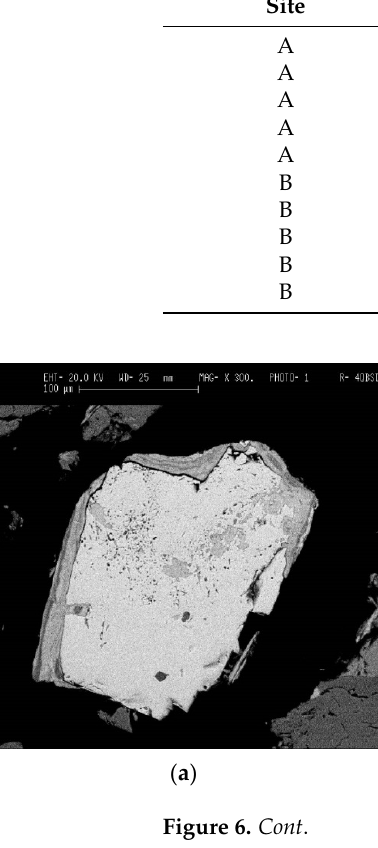
( d ) Figure 6. Phosphatic features investigated using SEM ‐ EDS analysis. ( a ) Phosphate bearing coatings and infillings on a sand grain (300× SEM image taken in backscattered electron imaging); ( b ) Phos ‐ phate bearing coatings on a vegetal remain (24× SEM taken in secondary imaging); ( c ) Phosphate bearing impregnations on a crumby microaggregate (1400× SEM image taken in secondary image on the left and backscattered electron imaging on the right); ( d ) Organo ‐ minerals associations (3000× SEM image taken in secondary image on the left and backscattered electron imaging on the right). 4. Discussion 4.1. Phosphorus Persistency through Phosphates The application of the Olsen P method, together with the ultramicroscopic analysis of the phosphatic features’ P 2 O 5 concentration, showed the evolution of bioavailable phos ‐ phorus and phosphates’ soil content due to corpse decomposition through time. The results show how the soils of the study area, sampled and analyzed before the pigs’ inhumation, were almost completely devoid of available phosphorus, probably due to the acidic soil parent material [30]. On the contrary, in all the specimens sampled below the swine carcasses after each exhumation, the anomalous concentrations of phosphorus and phosphates have been identified. In particular, the presence of a first peak of the con ‐ centration of both the analytes at a PBI of 47 days for site A and 42 days for site B (Figure 2 and 3) confirmed what has been affirmed in previous studies, which recognized an anal ‐ ogous peak concentration of the element after 36 days [12] and 40 days [13]. This soil con ‐ dition can be attributed to an input of the chemical element from cadavers because the tissues store proteins, sugar phosphates, phospholipids, and other many compounds [35,36] and can be released to the environment during the decomposition processes. In our study cases, a second peak of bioavailable phosphorus is also observable about one year post burial (396 days PBI, concentration of P av equal to 115.79 mg/kg) for site A